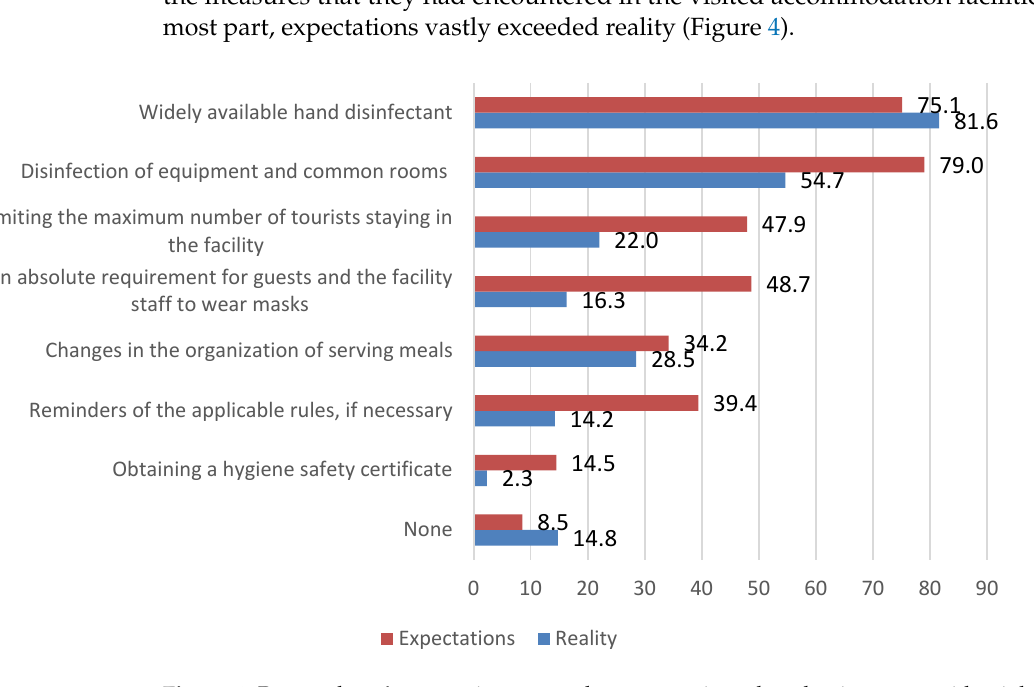
Figure 4. Respondents’ expectations towards measures introduced to improve epidemiological safety by accommodation facilities and actual measures encountered during the stay (in %, n = 386). The respondents could indicate more than one answer. Source: self-conducted research.